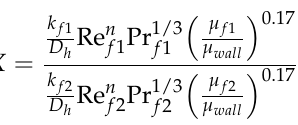
A correlation between the convective heat transfer coefficients of water on the plate and shell sides of the PSHE was represented by Equations (16) and (17). Here, f 1 and f 2 represent the fluids on the plate and shell sides, respectively.